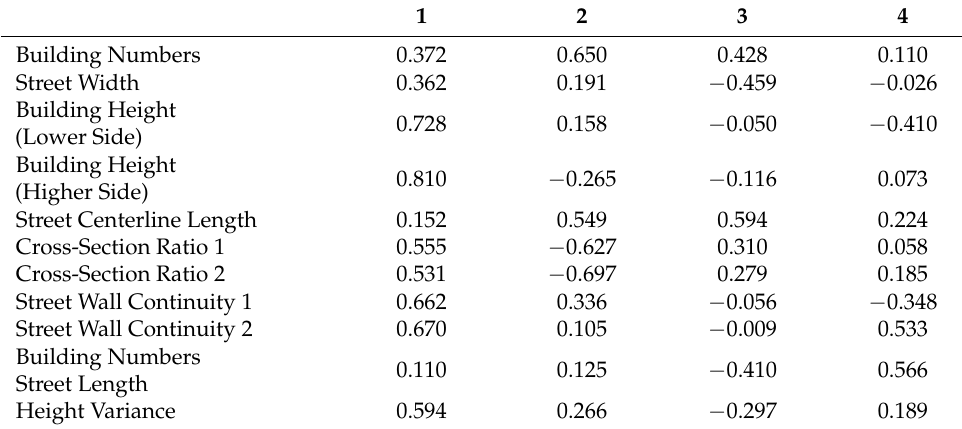
Table 4. Street Spatial Component Matrix.